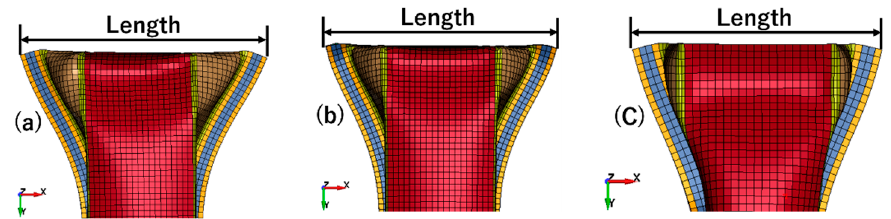
Figure 15. Comparison of slide degree under different friction condition: ( a ) = 0.05; ( b ) = 0.10; ( c ) = 0.20.